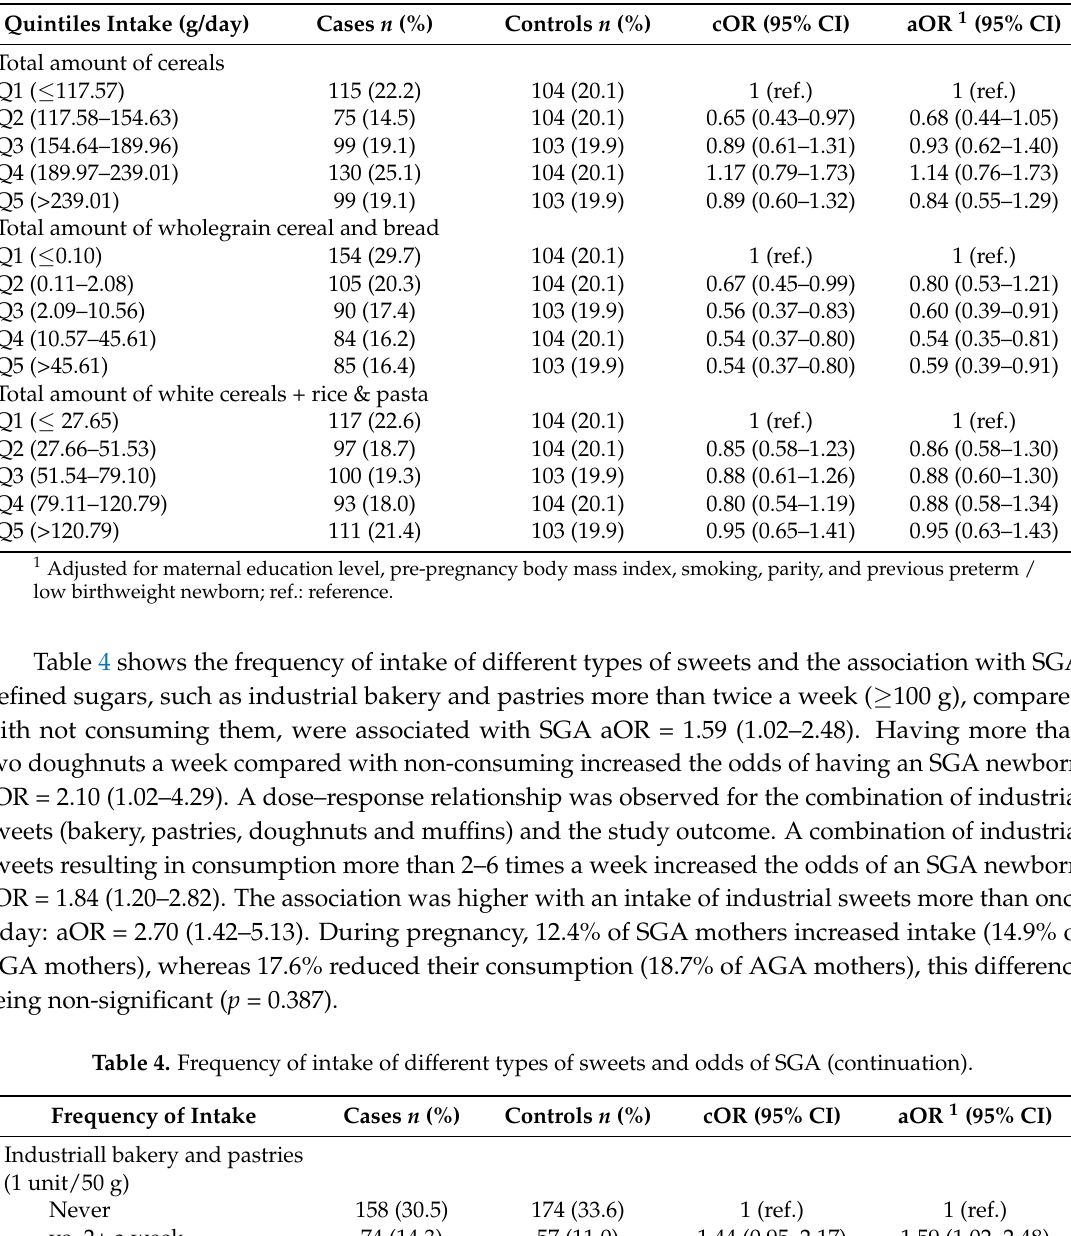
Table 3. Daily intake (g/day) of cereals and odds of having a small at gestational age (SGA) newborn.